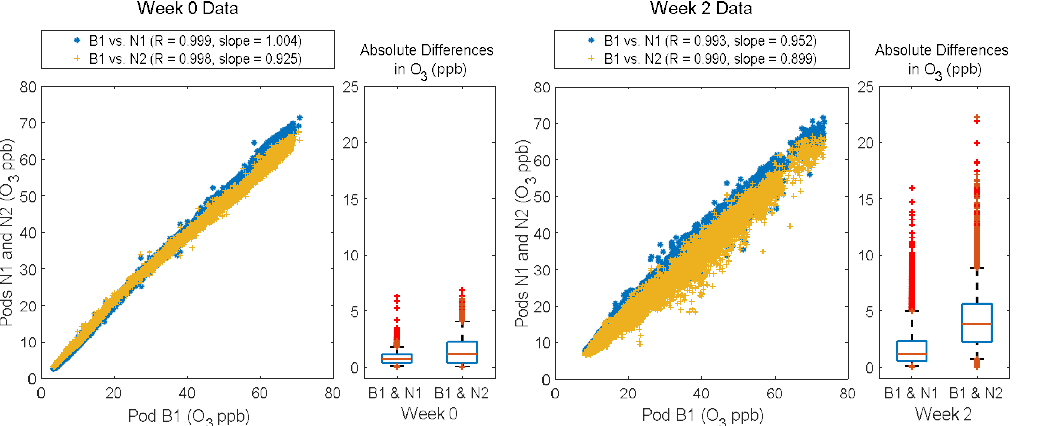
Figure 4. Scatter plots showing each neighborhood Y-Pod (N1, and N2) vs. Y-Pod B1 for Weeks 0 and 2.